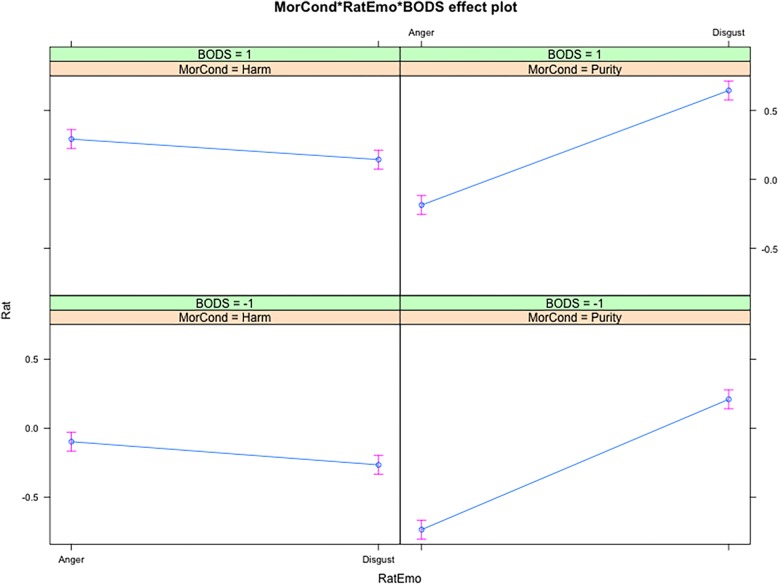
Interaction effects of BODS, Moral Condition and Rated Emotion on affective ratings. Results are displayed for levels of BODS = –1 SD (upper panels) and BODS = +1 SD (lower panels). MorCond, Moral Condition (Harm vs. Purity); RatEmo, Rated Emotion (Disgust vs. Anger); BODS, Body Odor Disgust Scale score.